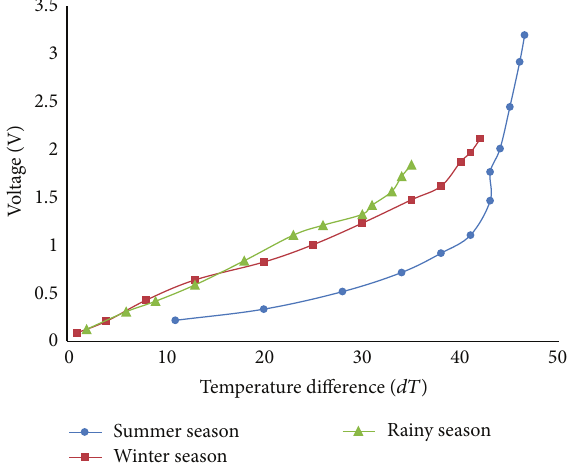
Figure 6: Comparison of temperature difference versus voltage in the duration of 11.00 am to 1.00 pm by using thermoelectric generator.